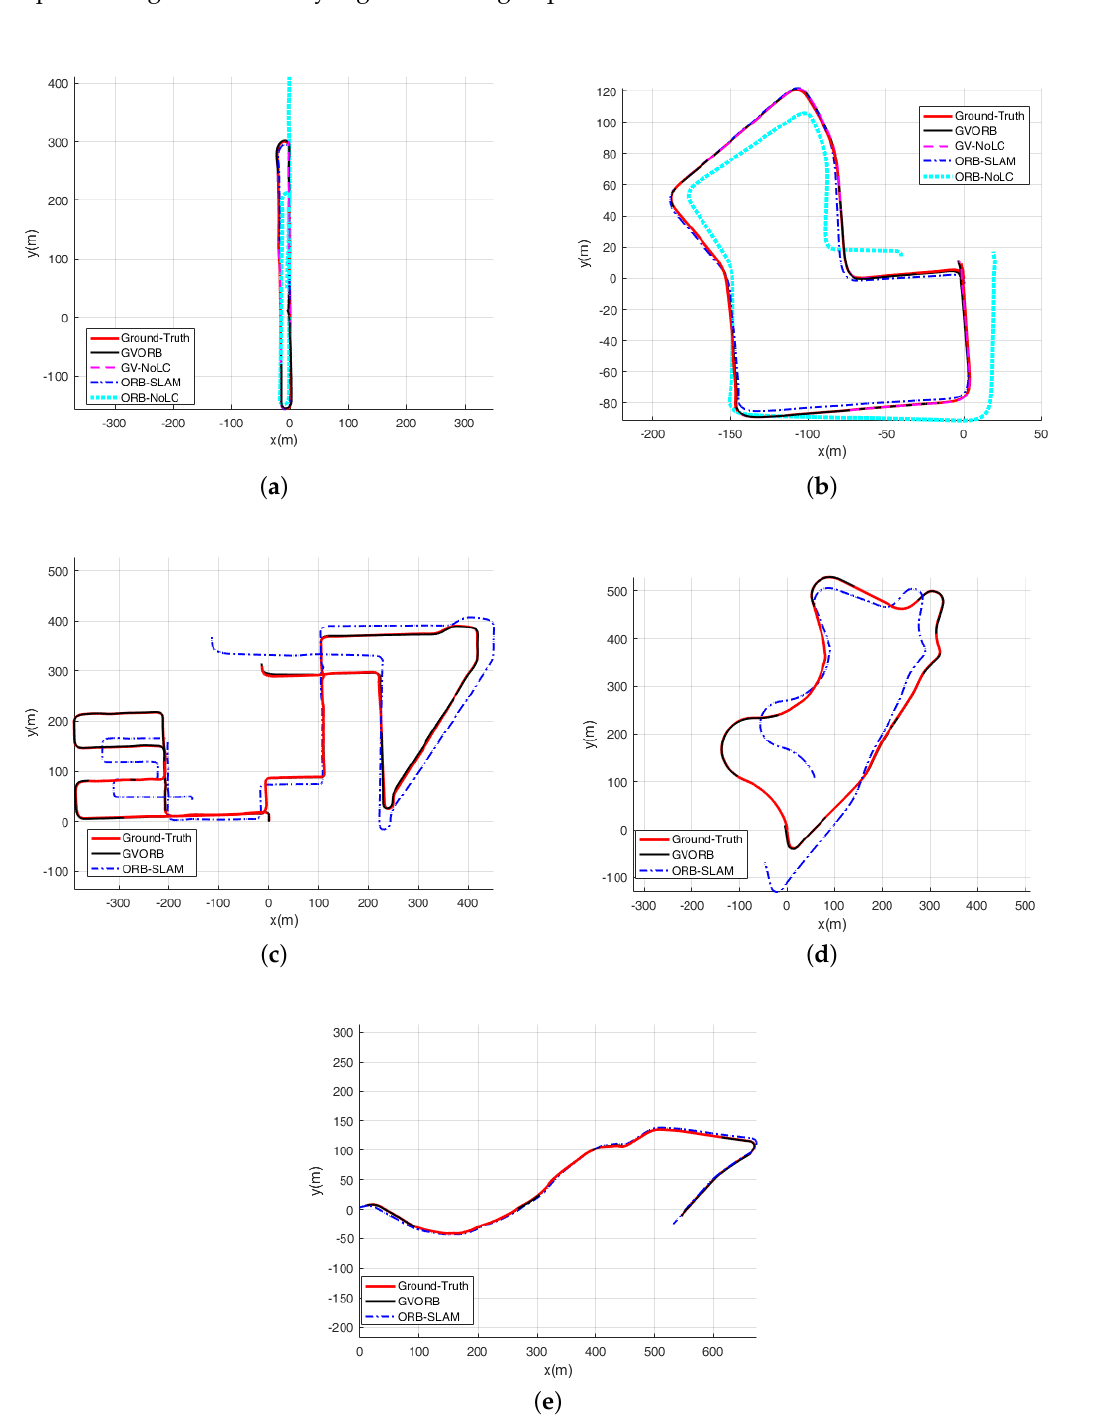
Figure 7. Localization results using the KITTIdataset. blackThe subfigures correspond to sequences 06–10: ( a ) Sequence 06; ( b ) Sequence 07; ( c ) Sequence 08; ( d ) Sequence 09; ( e ) Sequence